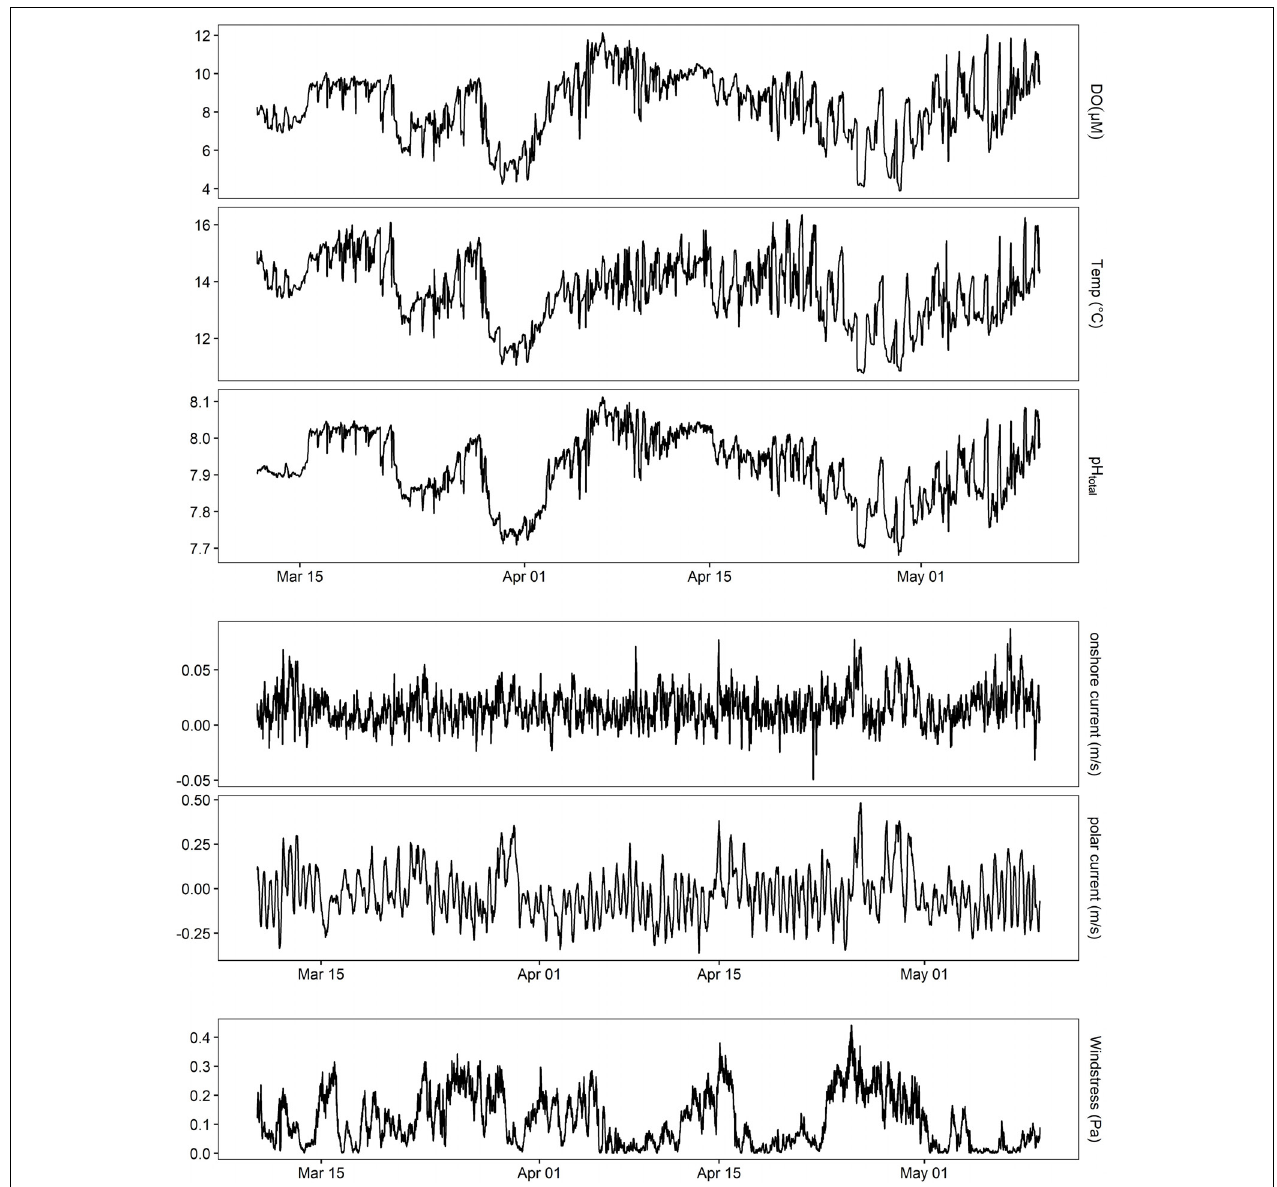
FIGURE 4 | pH, oxygen, and temperature outside of the kelp forest on the benthos at MKO during an extreme upwelling event for Deployment 3 (March–May 2016 shown). Also shown is ADCP data from the same site, rotated into principal components, and wind stress calculated from NOAA NBDC